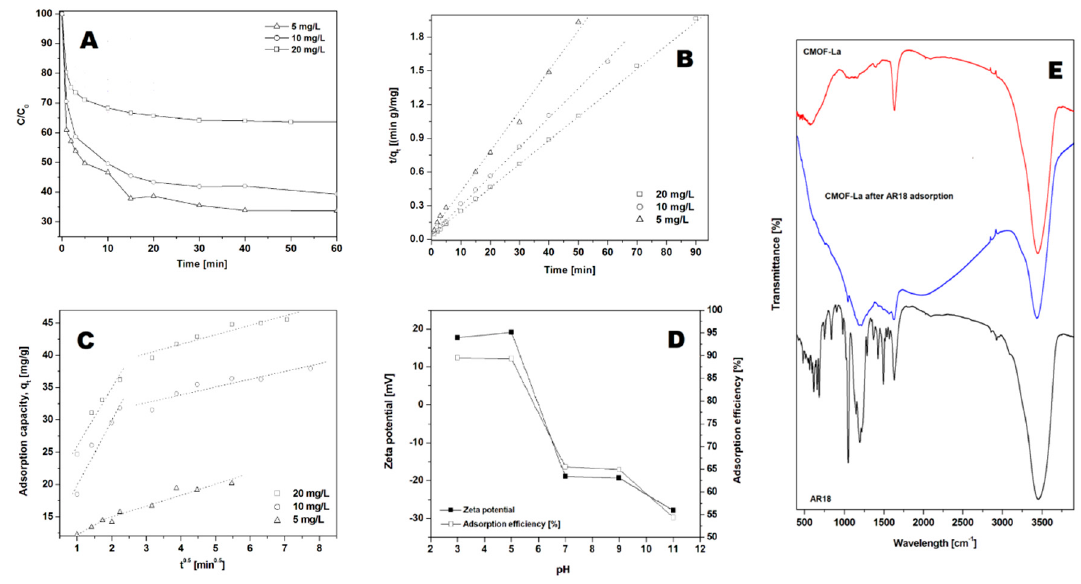
Figure 5. Effect of initial dye solution concentration ( A ) on adsorption capacity of the acid red 18 (AR18) onto CMOF. Pseudo-second-order kinetics ( B ) and intraparticle diffusion model ( C ) of acid red 18 adsorptions onto CMOF. Influence of initial pH and Zeta potential on dye adsorption ( D ). Experimental conditions: T = 20 °C, pH = 7. FT-IR spectra of carbonized MOF, CMOF after adsorption and AR18 ( E ). Table 1. Parameters for the adsorption of acid red 18 onto acid treated carbonized La based metal- organic frameworks (CMOF).